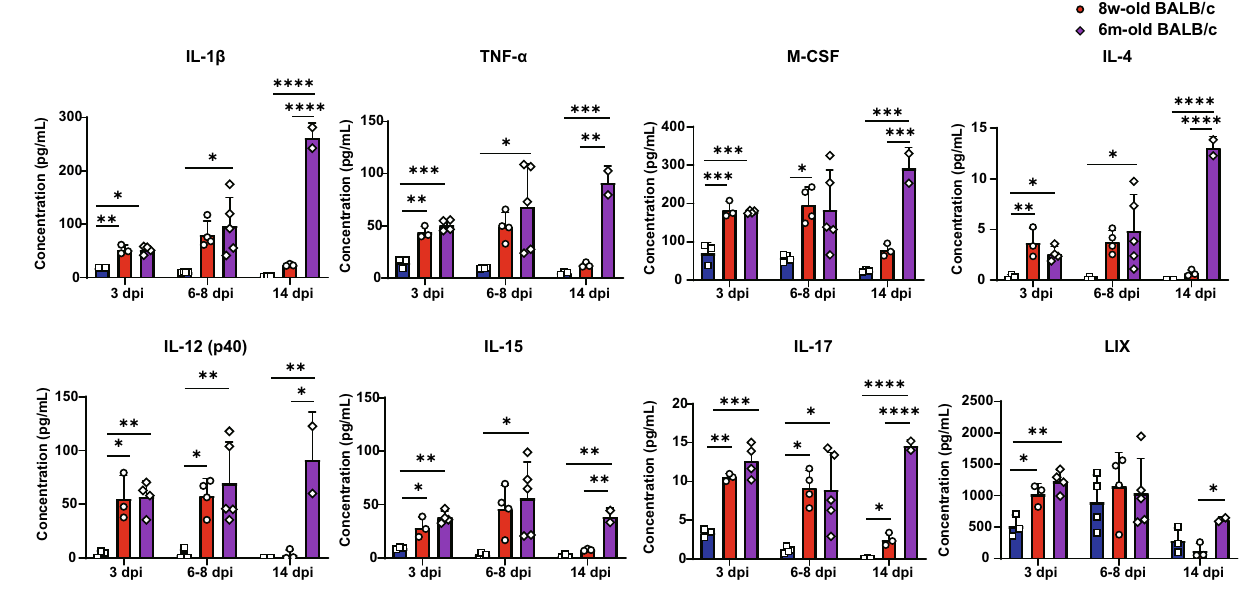
Figure 4. Cytokines and chemokines with higher expression levels in young and aged BALB/c mice compared to those in young C57BL/6 J mice from early to middle phase of SARS-CoV-2 infection. Left-lung homogenates in HBSS were used to measure multiplex cytokines and chemokines using the Bio-plex suspension array system. Of the 32 cytokines and chemokines measured, eight are shown in this figure. Data are presented as mean ± SD. (young group, n = 3–4 per time point; aged group, n = 2–5 per time point). P-values were calculated using one- way ANOVA followed by Tukey’s test. Asterisks indicate significant differences among young C57BL/6 J, young BALB/c, and aged BALB/c